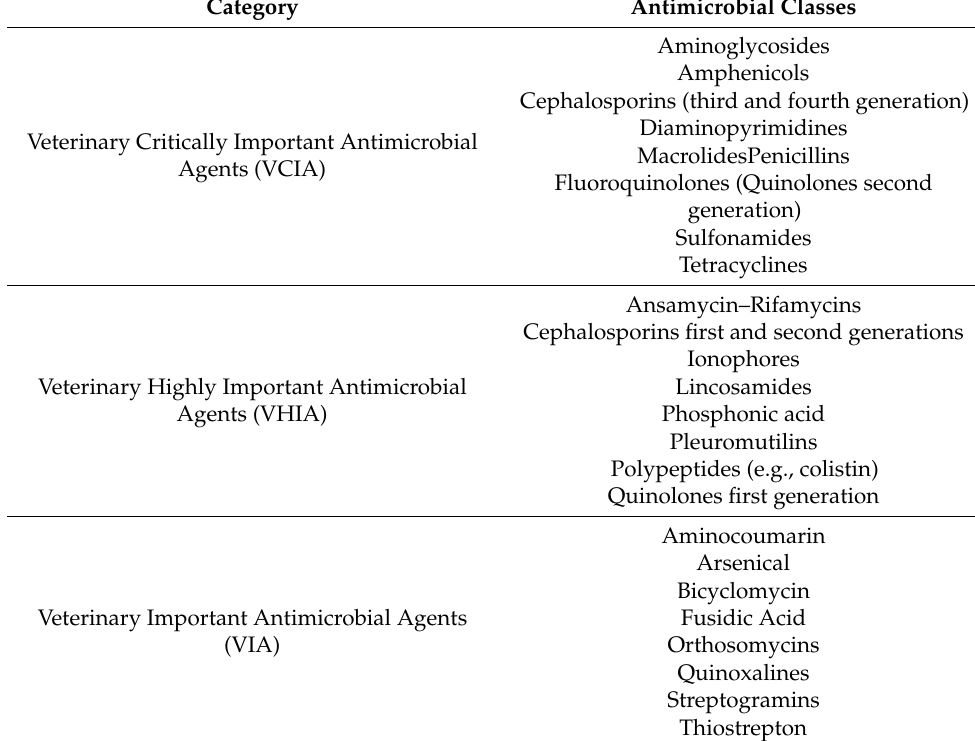
Table 1. OIE classification of antimicrobials regarding their importance for animal health. Category Antimicrobial